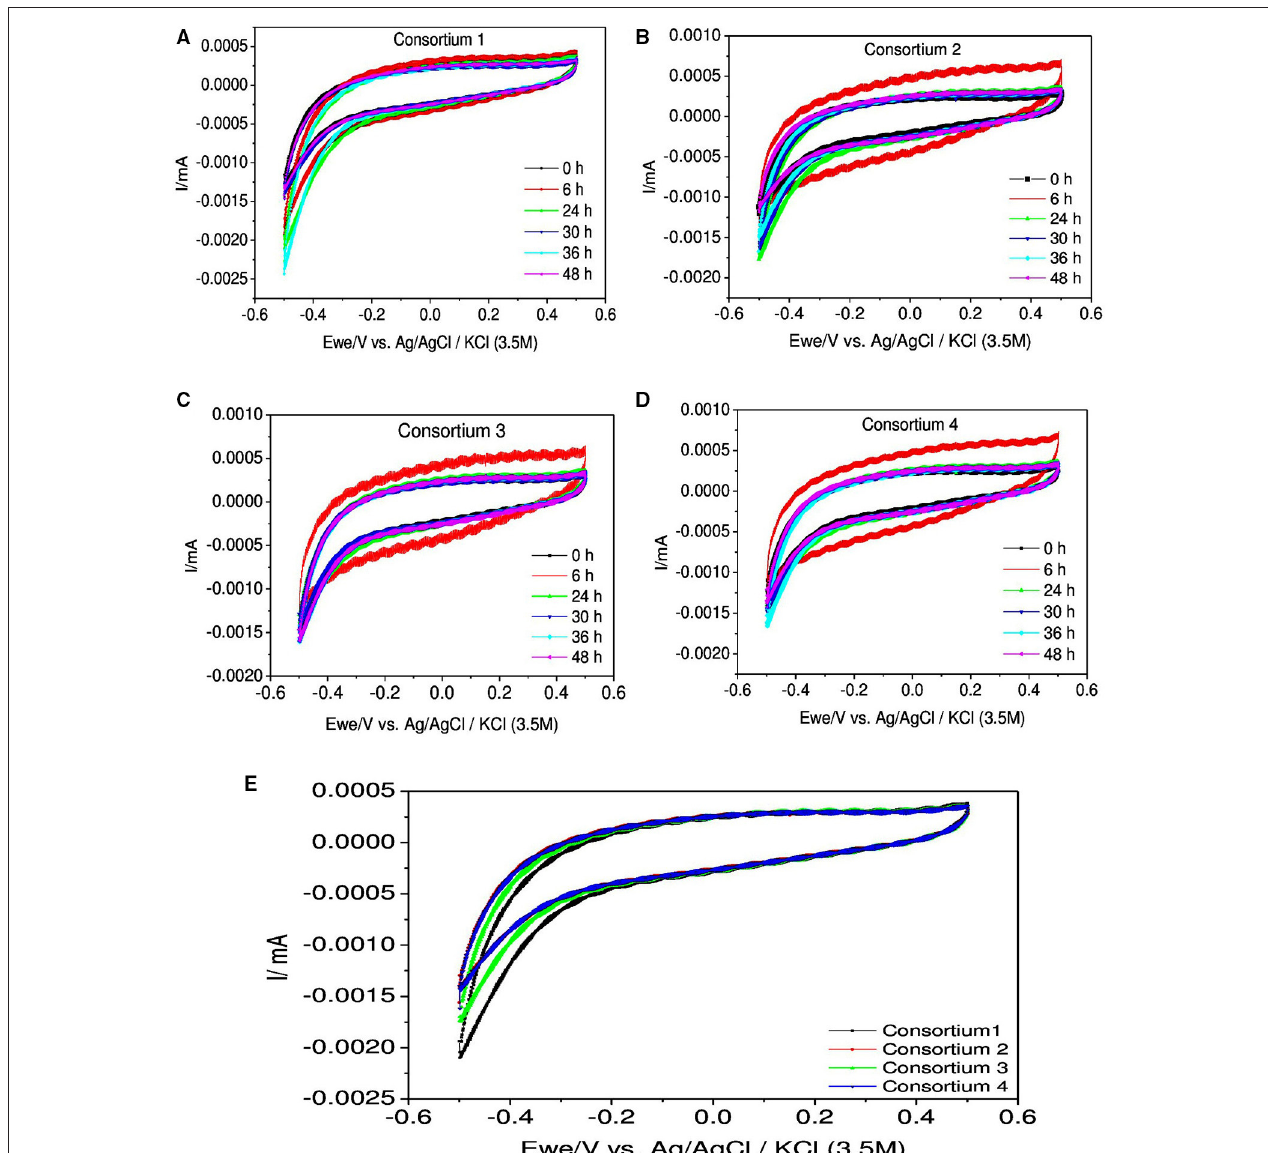
FIGURE 10 | Cyclic voltammograms depicting the redox catalytic currents in (A) Consortium 1, (B) Consortium 2, (C) Consortium 3, (D) Consortium 4, and (E) All Consortia at 24h recorded at a scan rate of 20mV s − 1